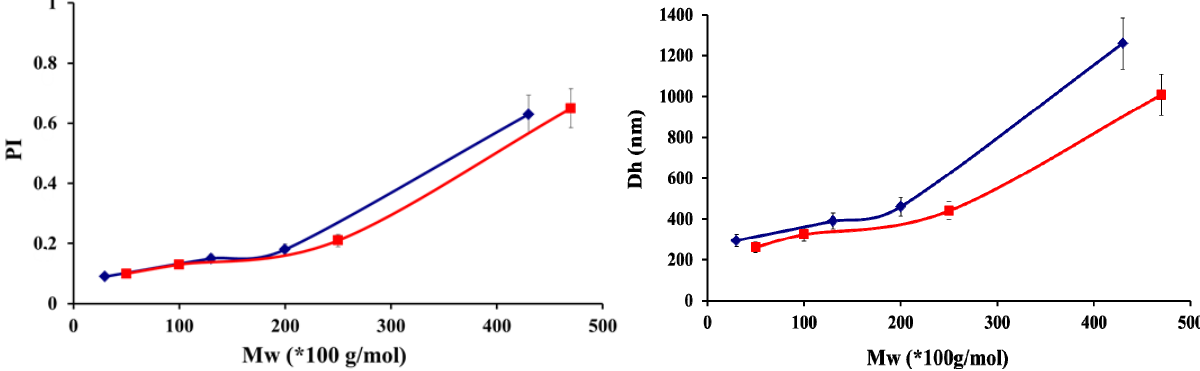
Figure 4. Influence of chitosan molar masses (Mw) on the sizes and polydispersities (PI) of polyelectrolyte complex particles for DA 5% (  ) and 48% (  ) obtained with hyaluronic acid molar mass of 50 000 g/mol at a ratio R = 1.5 in water. Data are the average of three independent experiments ± standard